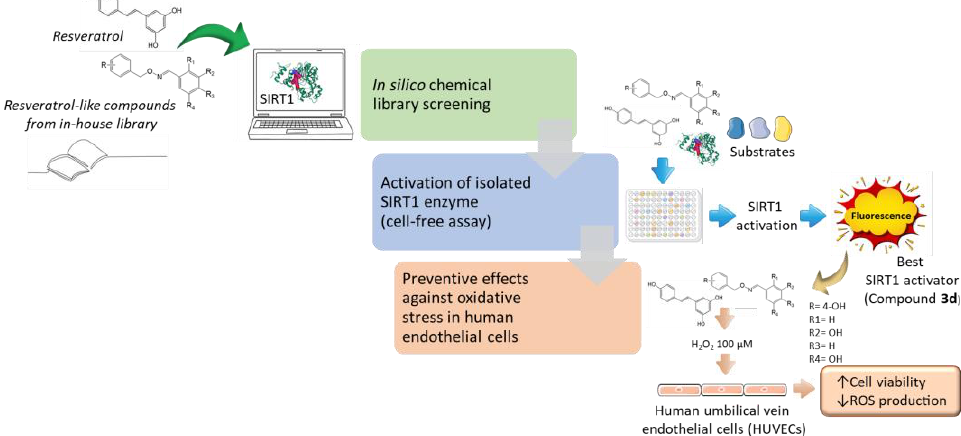
Figure 11. Summary of the work. Resveratrol-like compounds from our in-house library were first screened in silico to predict their ability to activate SIRT1 enzyme and bioavailability. Then, six selected compounds were tested in vitro to assess the potential activation of isolated SIRT1 enzyme. The best SIRT1 activator (compound 3d ) underwent pharmacological investigation in human endothelial cells (HUVECs). In this final set of experiments, both the reference SIRT1 activator resveratrol and compound 3d prevented H 2 O 2 -induced cell viability reduction and ROS production, likely via activation of